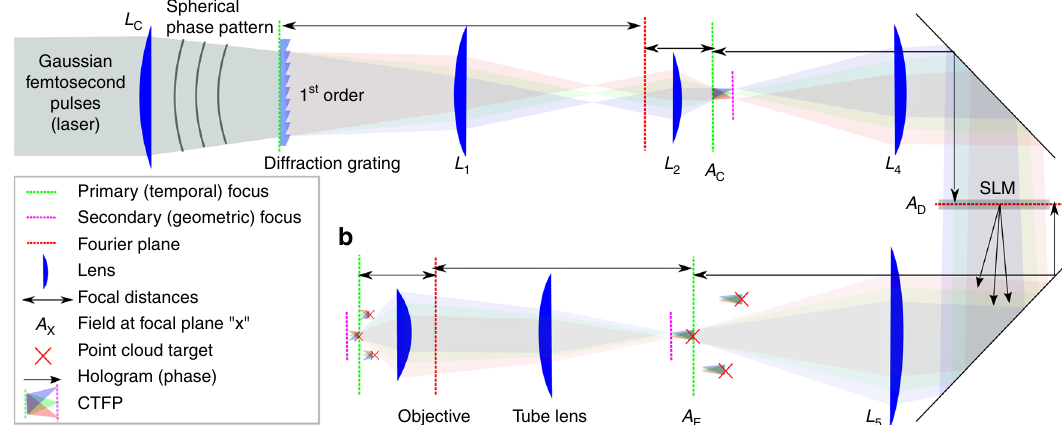
Fig. 1 Simpli fi ed experimental set-up for 3D-SHOT. a A spherical phase mask is applied to a Gaussian femtosecond laser pulse incident on a blazed diffraction grating. After the grating, the direction of propagation of the fi rst-order beam is wavelength-speci fi c, decomposing the pulse in the temporal domain. Temporal focusing and the associated nonlinear response thus only happens across a disc-shaped area at depth planes corresponding to images of the diffraction grating (dashed, green). We call this 3D intensity distribution a Custom Temporally Focused Pattern (CTFP). b We then copied this temporally focused disc pattern to different areas in 3D by computer generated holography (CGH). To do so, a spatial light modulator (SLM) in Fourier space (dashed, red) generates a point-cloud hologram that replicates the CTFP at each target point in the volume image. The resulting fi eld is demagni fi ed again before impinging on the sample to create custom 3D positioning of the temporally focused disk, each targeted at a particular